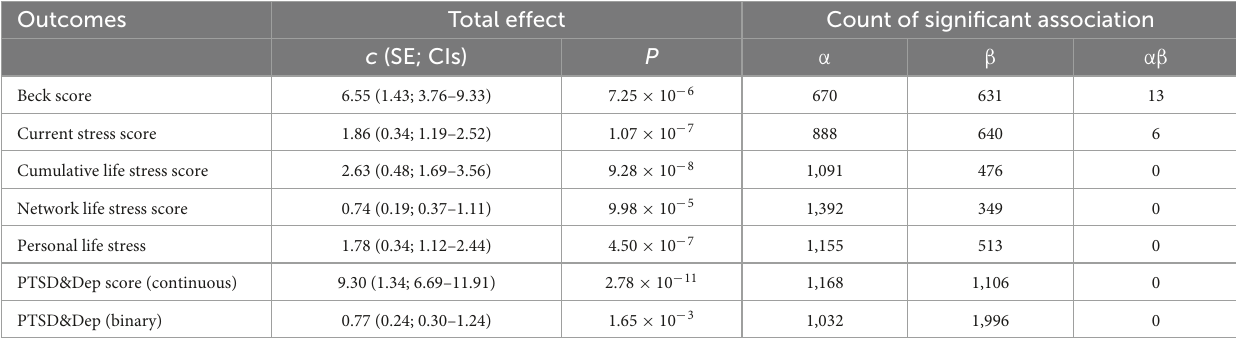
TABLE 2 Results of the gene-centric mediation analysis with childhood maltreatment as the exposure, DNA methylation CpG sites located within a gene as mediators, and PTSD and six PTSD-relevant scores as outcomes.